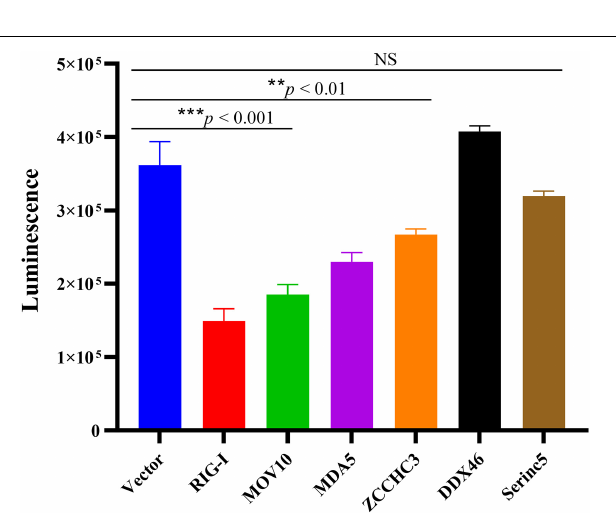
FIGURE 5 | Screening of ISGs using rSVA-Nluc infection. BHK-21 cells were transfected with ISGs followed by infection with rSVA-Nluc at an MOI of 0.1 for 48 h and assayed for Nluc activity. The data are presented as the mean ± SD from three experiments. The statistical significance of differences was determined using Student’s t -test (NS, not significant; * p < 0.05; ** p < 0.01; *** p <